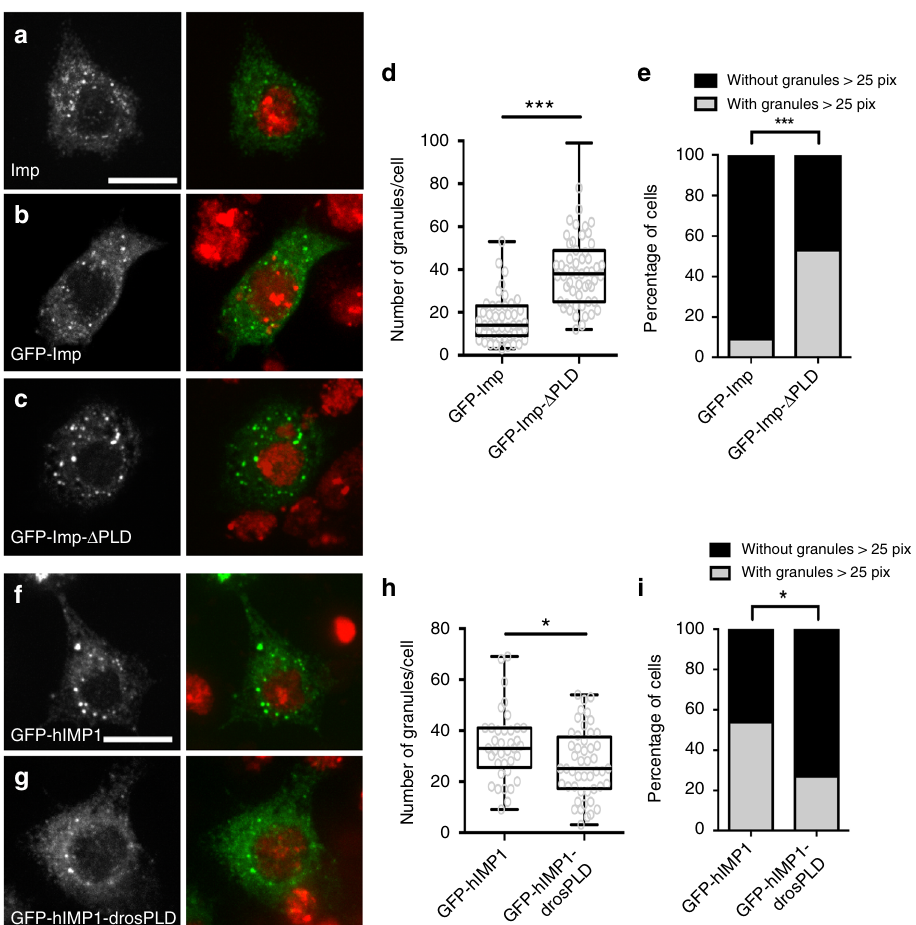
Fig. 7 Imp PLD modulates granule size and number. a S2R + cell stained with anti-Imp antibodies (left, green in the overlay), and DAPI (red in the overlay). b, c S2R + cells transfected with GFP-Imp ( b ), or GFP-Imp- Δ PLD ( c ) constructs, and stained with DAPI (red in the overlay). GFP signals are shown in white (left) and green in the overlay (right). Scale bar in a – c : 10 μ m. d Distribution of cells in function of their number of GFP-Imp (left) or GFP- Imp- Δ PLD (right) granules. *** P < 0.001 (Mann – Whitney test). e Percentage of cells exhibiting granules larger than 25 pixels. *** P < 0.001 (Fisher ’ s exact test). 47 and